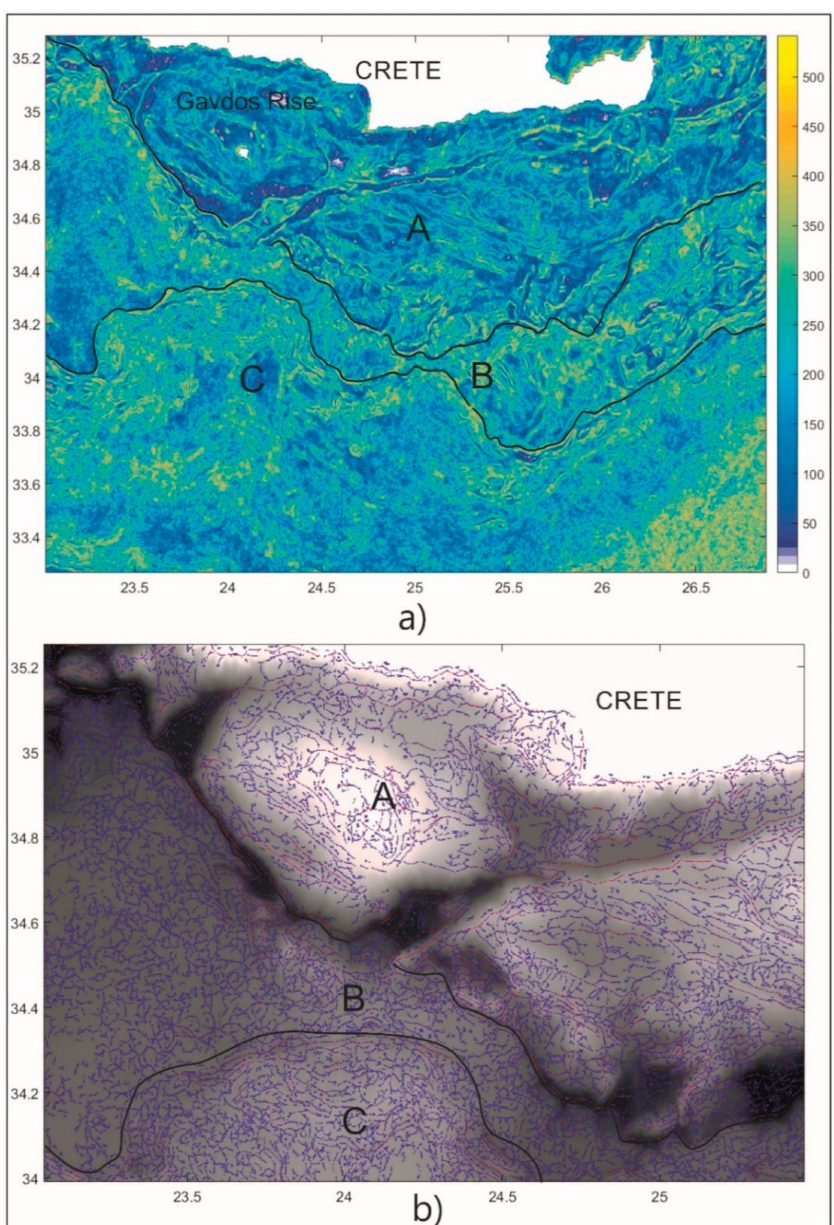
Figure 3. Automatic detection of the seafloor skeleton in the Southern Cretan o ff shore using medium resolution (0.25 arc minutes) data from EMODNet (European Marine Observatory and Data Network) [28]. The reference system is WGS84. ( a ) The output of the multiple filtering approach [34]. Color scale corresponds to the strength of the detection ranging from 0 (blue) to 550 (yellow) with no units. ( b ) The skeleton (medial axes) overlain the bathymetric relief. The red lines correspond to strongly detected linear and curvilinear elements, while the blue lines correspond to weak ones. On the basis of signal texture (strength of the detection, length, direction, and spatial distribution of the lineaments), we divided the area into three sub-regions (A, B, and